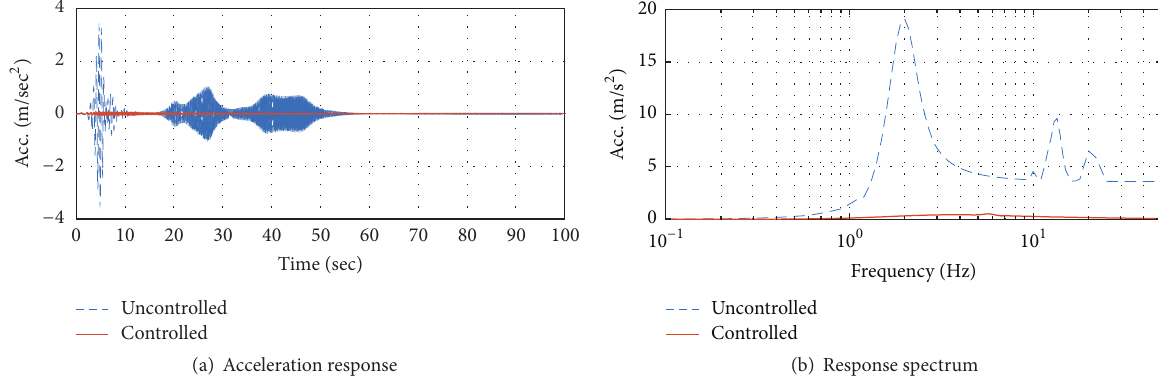
Figure 11: Response of piping system subjected to sine sweep wave ( 𝑦 -direction load versus 𝑧 -direction response).